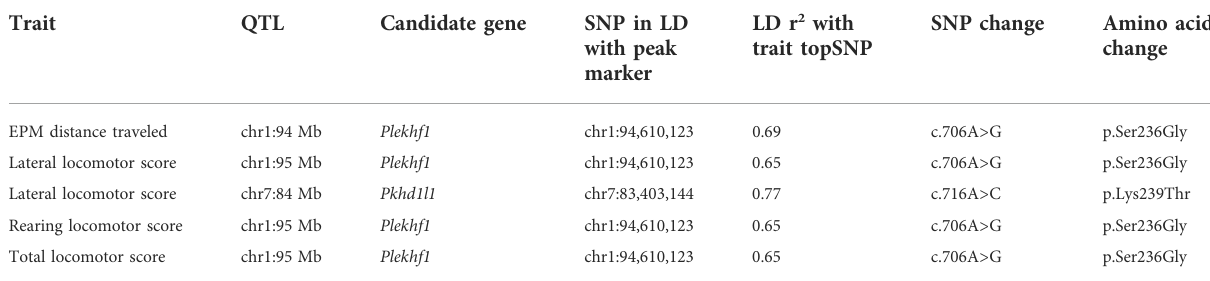
TABLE 5 Summary of putatively causal coding